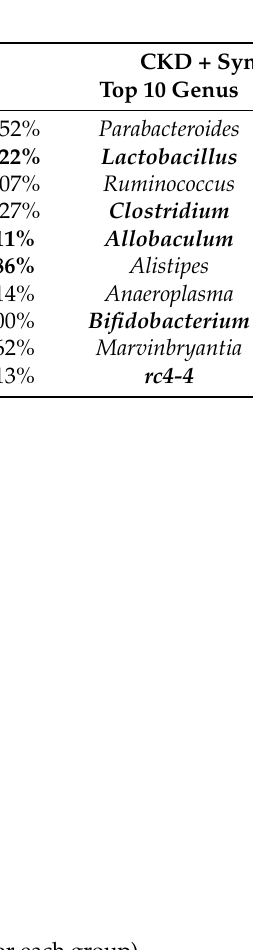
Figure 9. Gut microbiota diversity in the rat model ( n = 6 for each